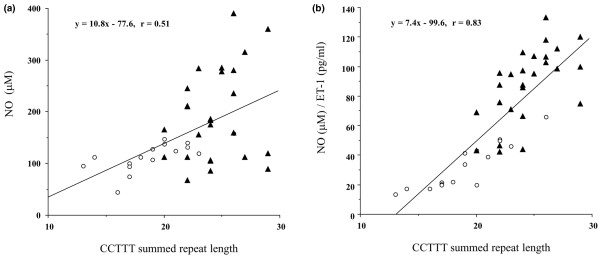
Relationship between NO levels or NO/ET-1 ratios and summed CCTTT repeat length. The association study between summed lengths of the CCTTT repeat and (a) serum NO levels and (b) NO/ET-1 ratios was performed in 16 patients with SSc with PAH (open circles) and 26 patients with SSc without PAH (black triangles). The results of linear regression analysis of the data are represented by the solid line. Serum NO levels and NO/ET-1 ratios were significantly correlated with summed CCTTT repeat lengths (r = 0.51, P < 0.01; and r = 0.83, P < 0.0001, respectively). ET, endothelin; NO, nitric oxide; PAH, pulmonary arterial hypertension; SSc, systemic sclerosis.